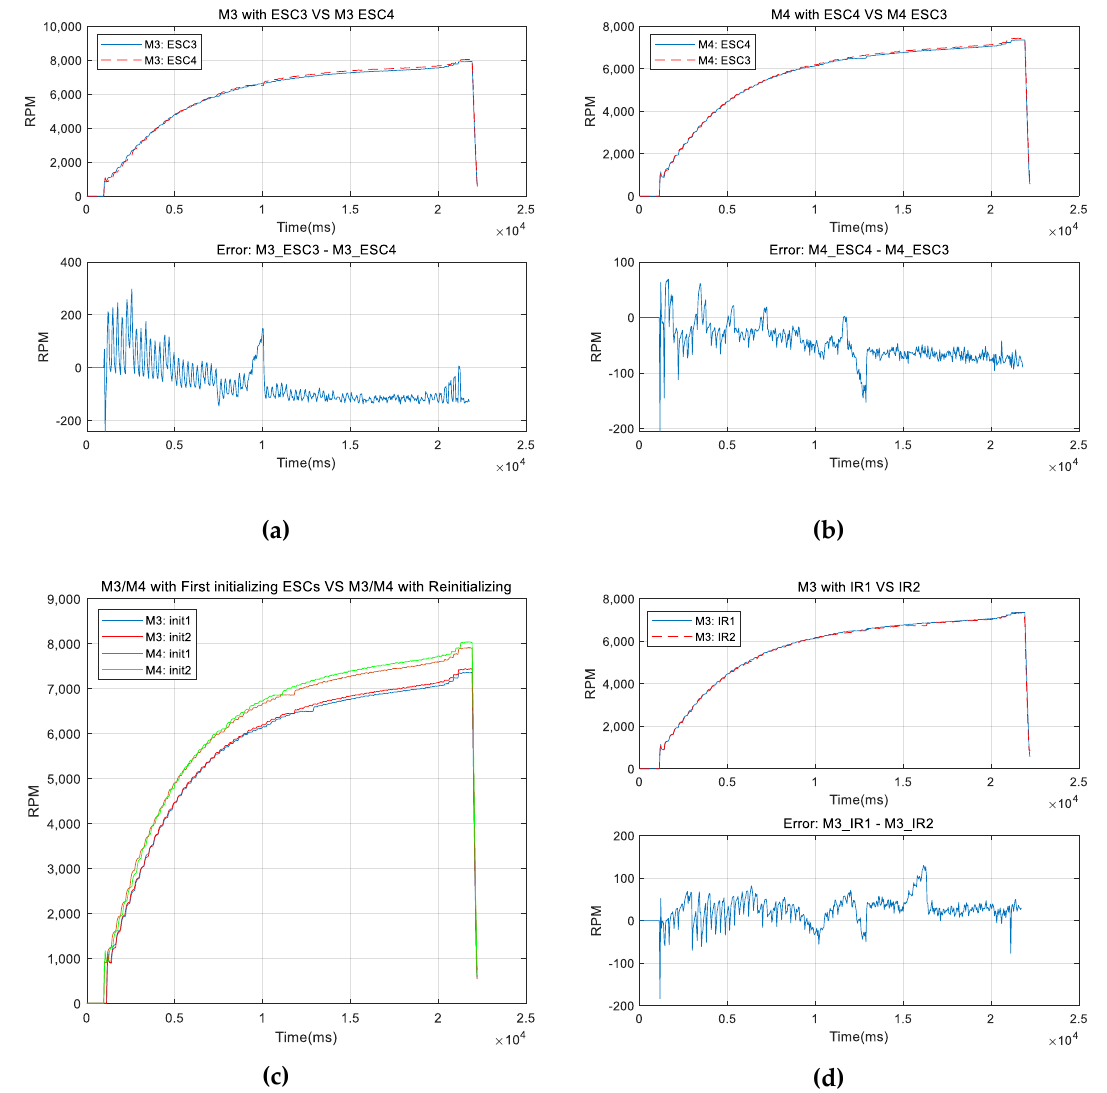
Figure 10. The results of Experiment C to find the cause of the speed error. ( a ) The experiment of the electronic speed controller’s (ESC) replacement: ESC3 to ESC4 in M3; ( b ) the experiment of ESC’s replacement: ESC4 to ESC3 in M4; ( c ) the experiment after re-initialization of ESCs; ( d ) the experiment of the infrared sensor